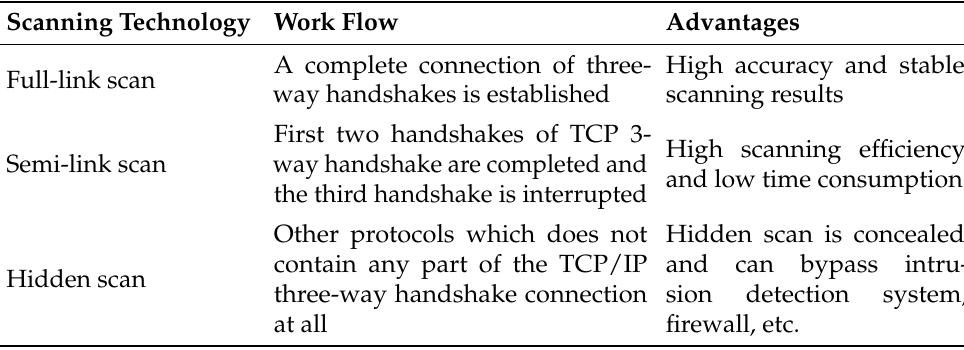
Table 1. Comparison of scanning